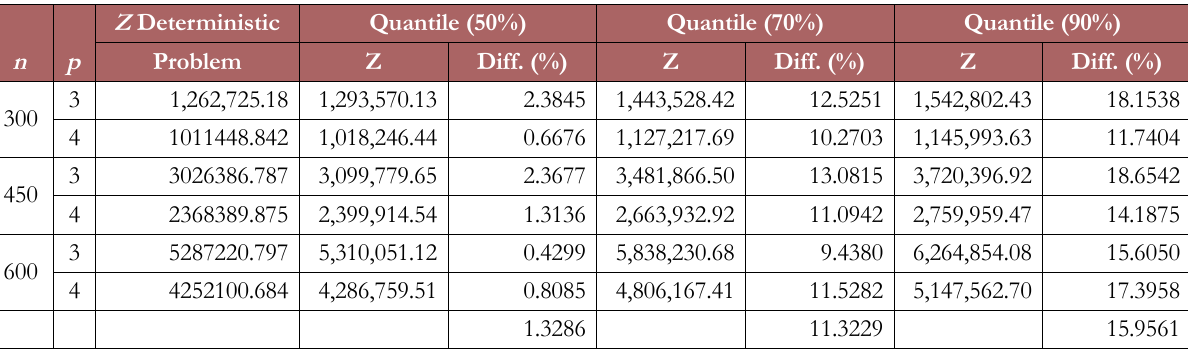
Table 2. The experimental results summary on the stochastic